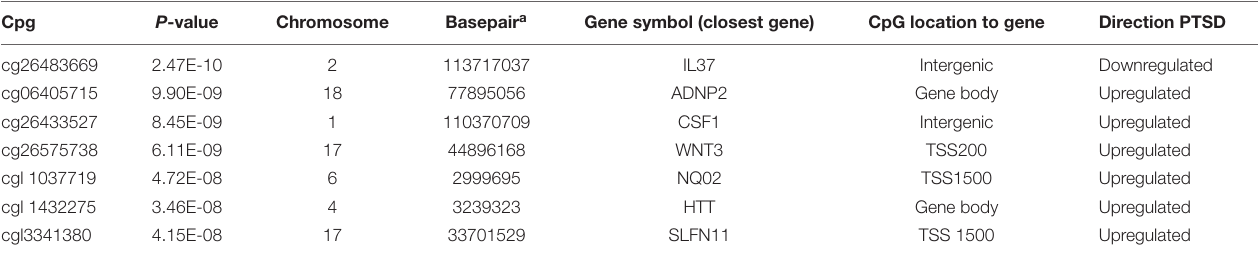
TABLE 3 | List of CpG sites significantly associated with PTSD at Bonferroni threshold for significance ( p < 5.77 × 10 − 8